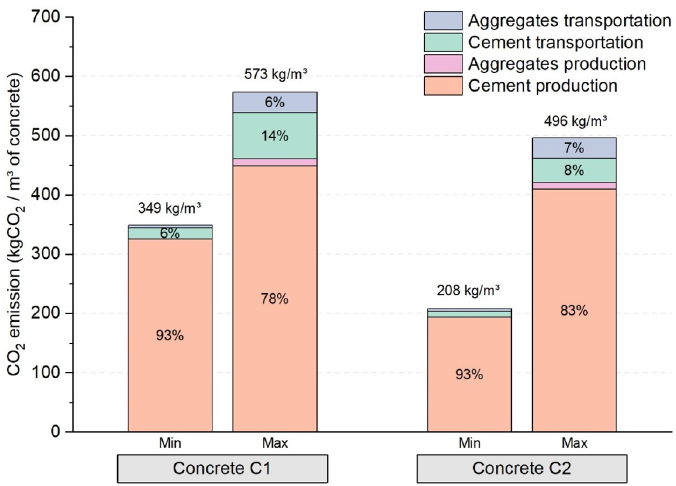
Figure 6. Minimum and maximum CO 2 emissions from C25 concrete with C1 and C2